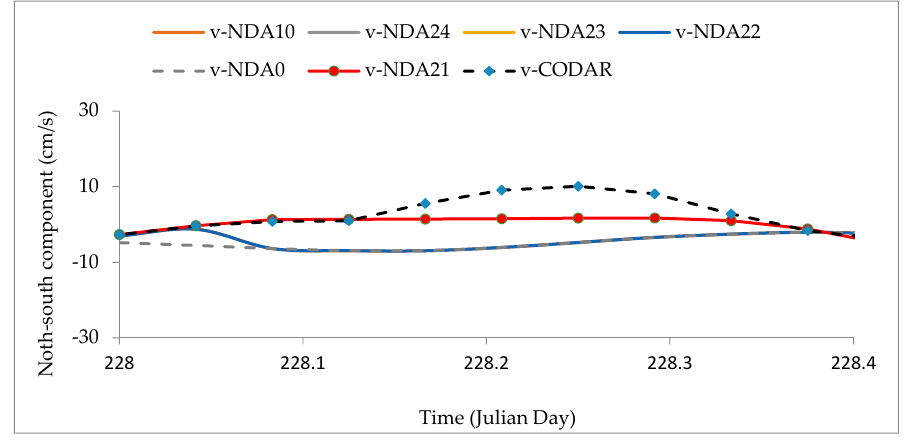
Figure 9. Time series of north–south velocity component.